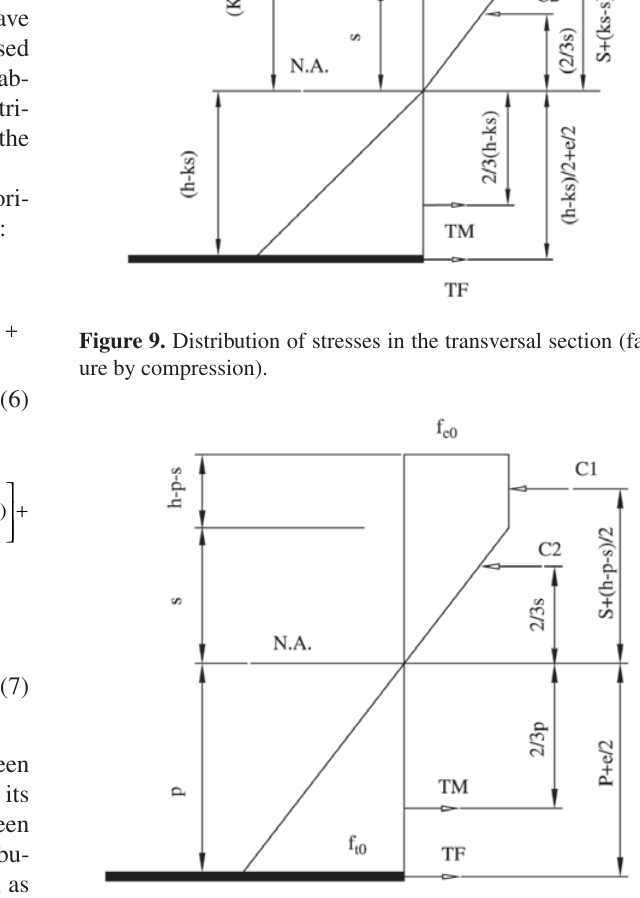
Figure 10. Distribution of stresses in the transversal section (fail- ure by traction in the